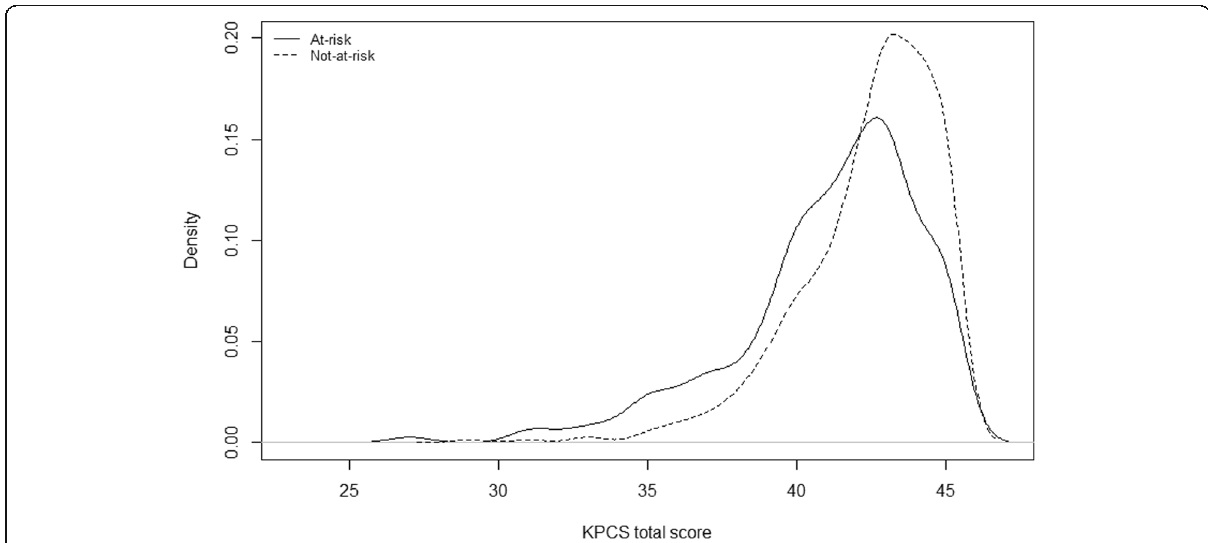
Fig. 2 Density plot of KPCS mean scores for at-risk and not-at-risk mothers at six